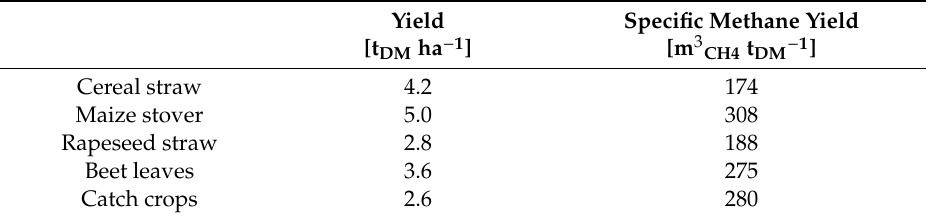
Table 1. Assumptions regarding yield (in tons of dry matter per hectare) and specific methane yield for straw, beet leaves and catch crops (in cubic meters of methane per ton of dry matter) [24,29–32]. Yield